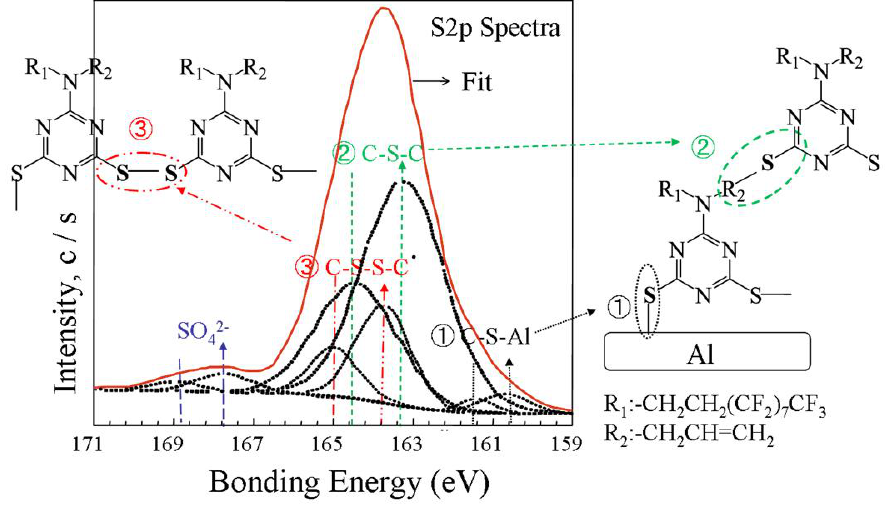
Figure 6. S2p fitted curve of high resolution XPS spectra from PAF17 nanofilm on aluminum plate at 45° tilt degree. Electropolymerization conditions (Current